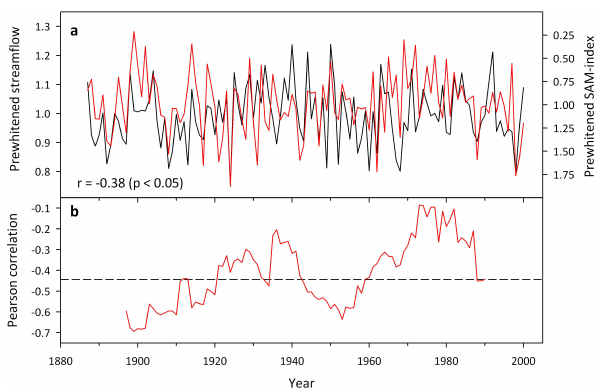
Fig. 8. (a) Relationship between the October–June Neuqu´en River streamflow (black) and annual SAM index (red) for the period 1887–2000. SAM index has been inverted to facilitate the compari- son with the streamflow data. (b) 21-yr central moving correlations between the streamflow and the annual SAM index. Dashed lines indicate the 95% significance level. Note the change in strength of this relationship over time.